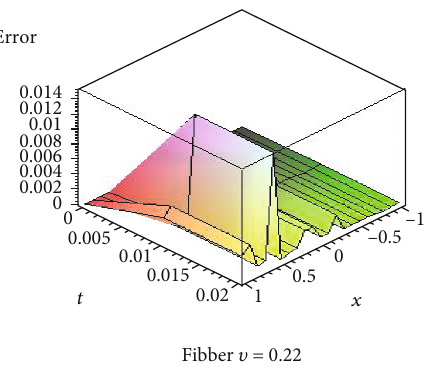
Fibber 𝜐 = 0.22 Figure 5: The value absolute error by PNM at N = 20 and T = 0 : 02 .